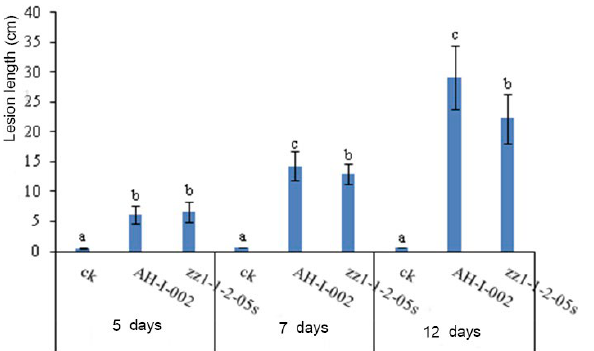
Figure 4. Necrosis length caused by Neofusicoccum man- giferae isolates (AH-I-002 and ZZ1-1-2-05S) inoculated on green detached grapevine shoots (N=9) after 5, 7 and 12 days. ck: non-inoculated control. Error bars indicate stand- ard deviation of the mean. Significant differences ( P <0.05) between means are indicated with different letters accord - ing to Duncan’s multiple range test.